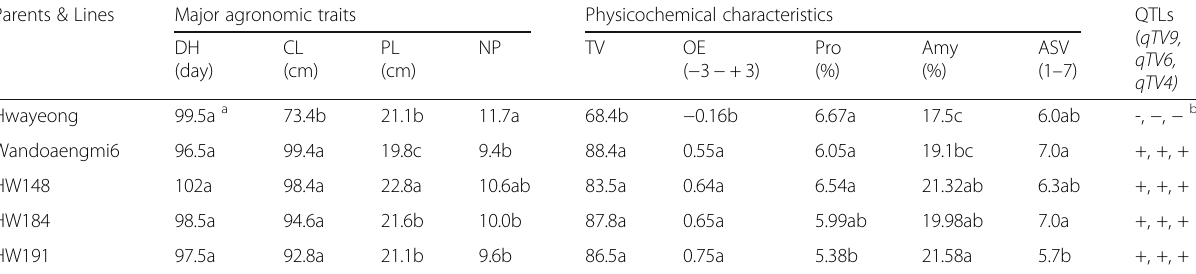
Table 5 Comparison of parents and selected promising three lines on agronomic performance and physicochemical characteristics including qTV9 Parents & Lines